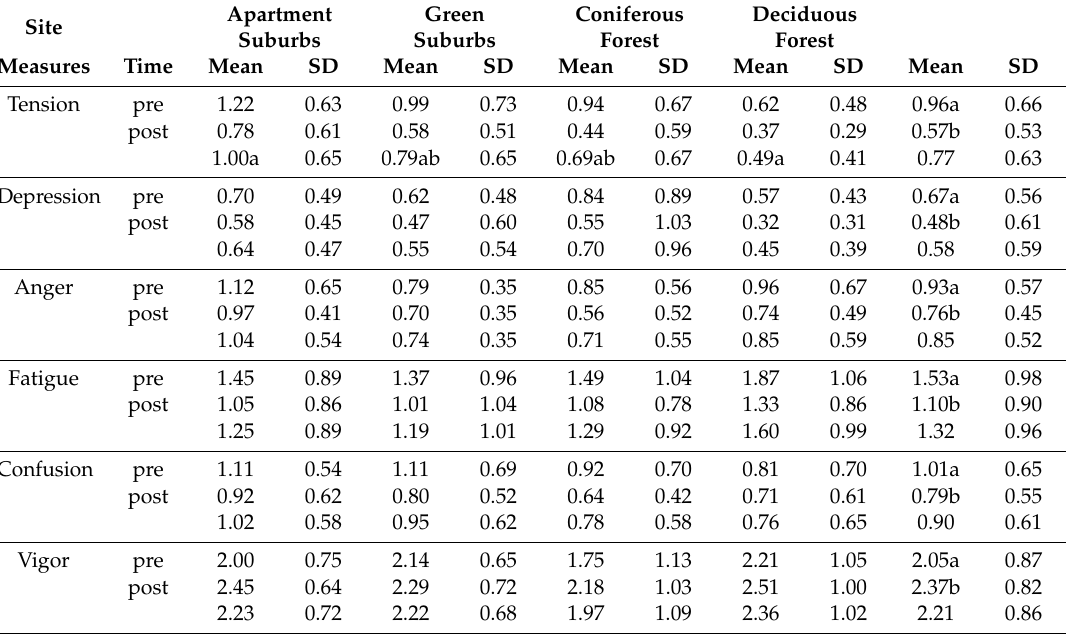
Table 5. Means and SD of psychological measures in four places during the experiment (for POMS